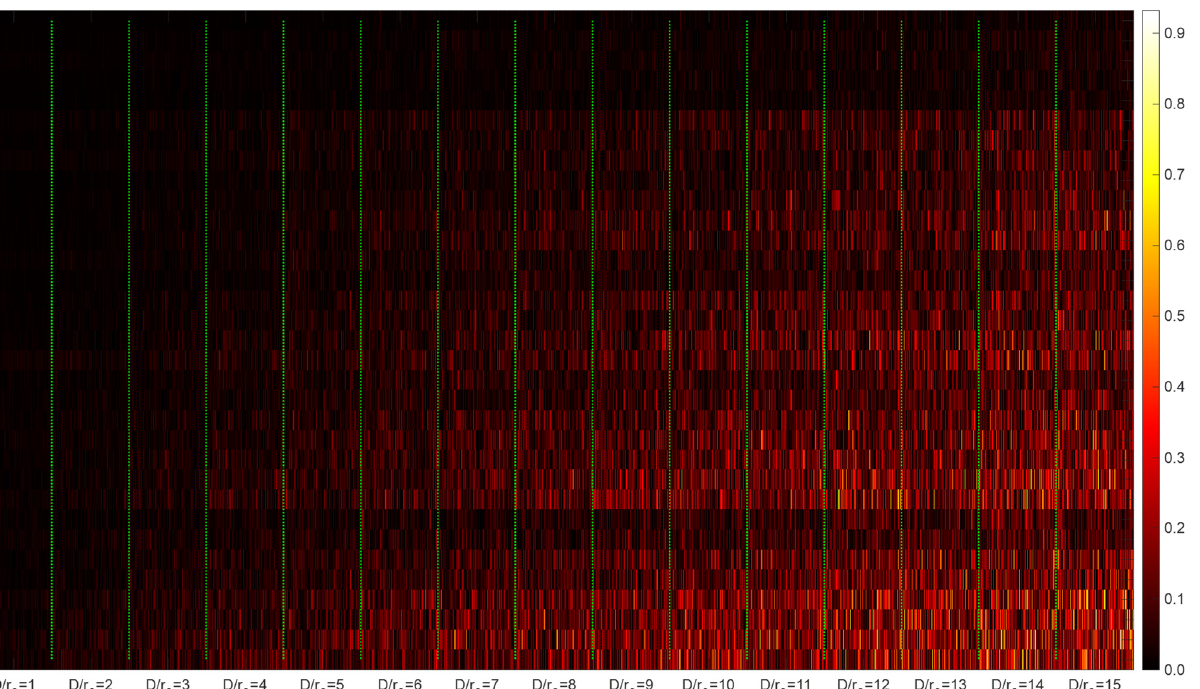
Figure 5. Four turbulence aberration samples for ( a ) D / r 0 = 1, ( b ) D / r 0 = 5, ( c ) D / r 0 = 10, ( d ) D / r 0 = 15: the first column is the real wavefront, the second column is the predicted wavefront by GoogLeNet S3 and the third column is the comparison of Zernike coefficients between the real wavefront and the predicted wavefront.